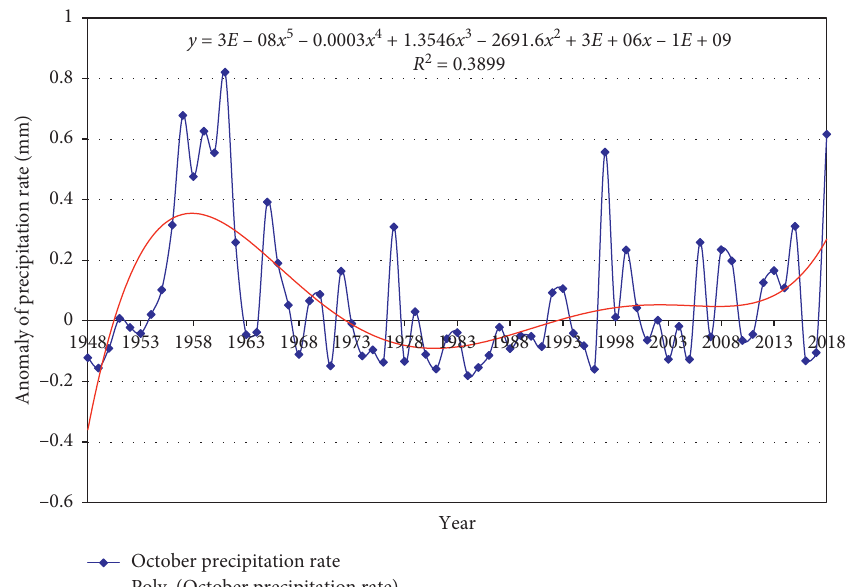
Figure 3: Time series of PR anomaly (mm/day) and its polynomial trend over the Arabian Peninsula, including SA in the month of October throughout the period